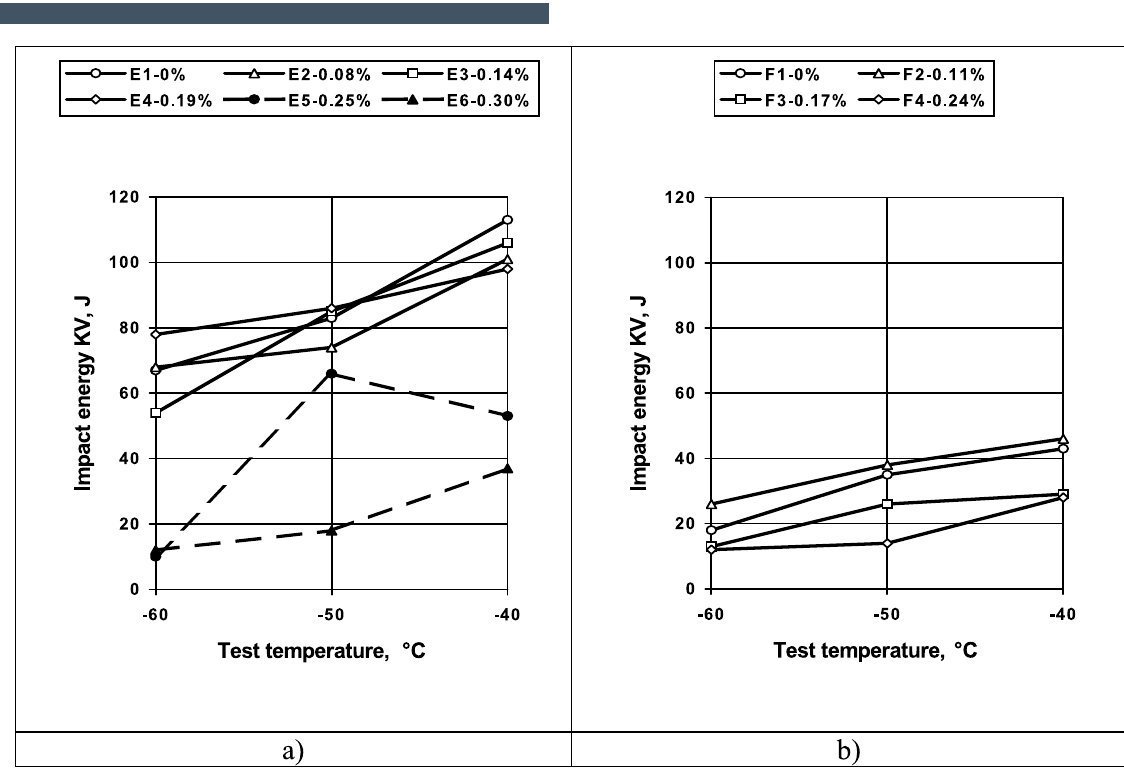
Figure 1. Impact energies at subzero temperatures of weld deposits of electrodes of series E and F (Table 6) as a function of Mo contents with P content of: a) ∼ 0.01%; b) ∼